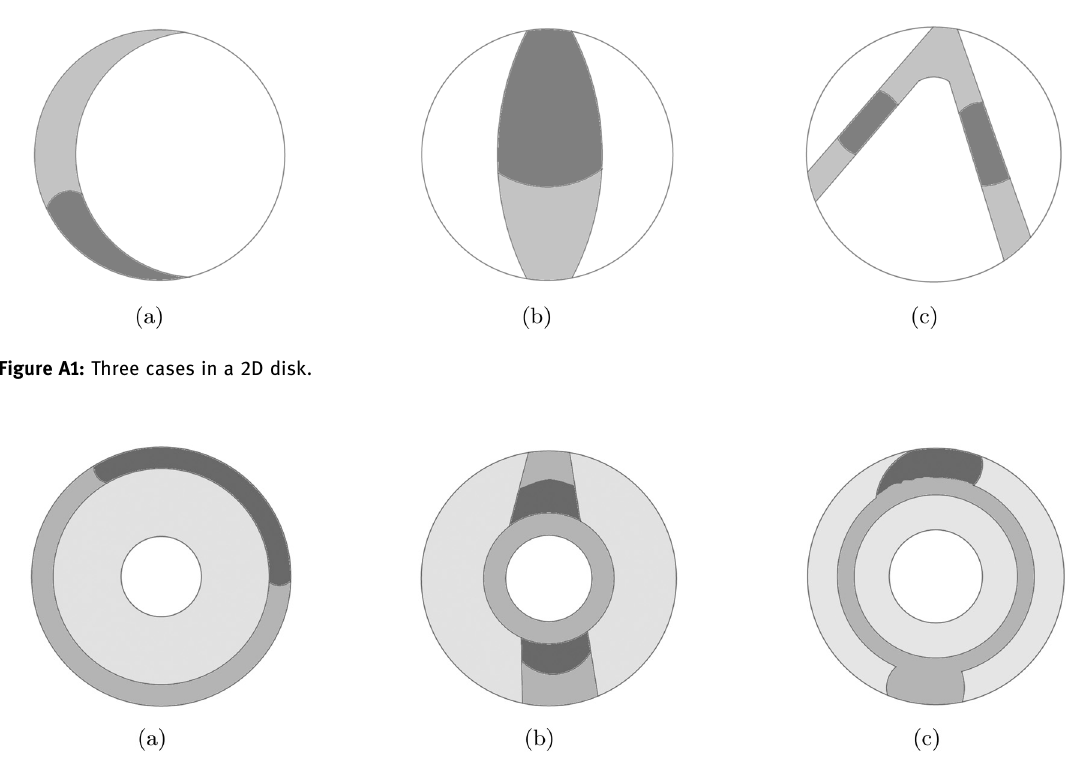
Figure A2: Three cases in a 2D